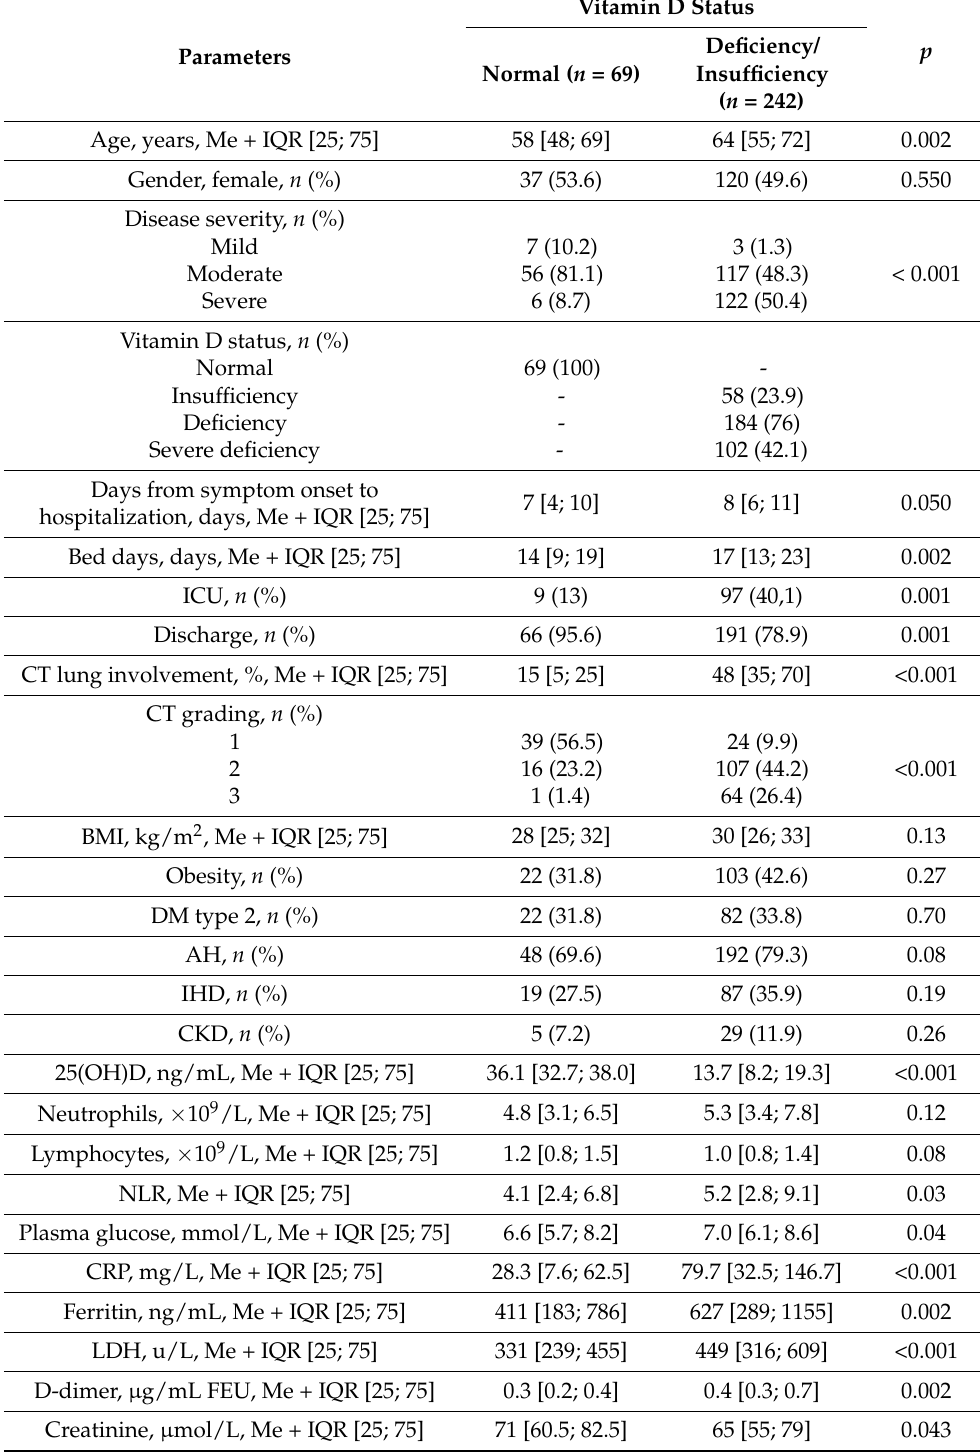
Table 2. Patients’ baseline characteristics depending on vitamin D